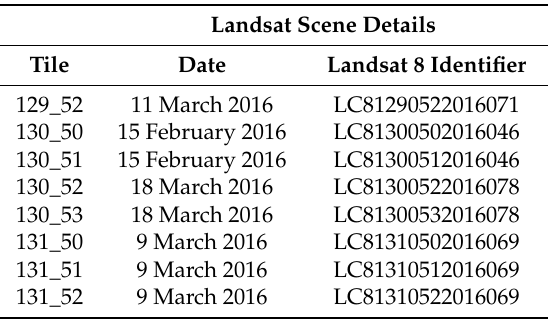
Table A1. Landsat scenes and tiles used in the